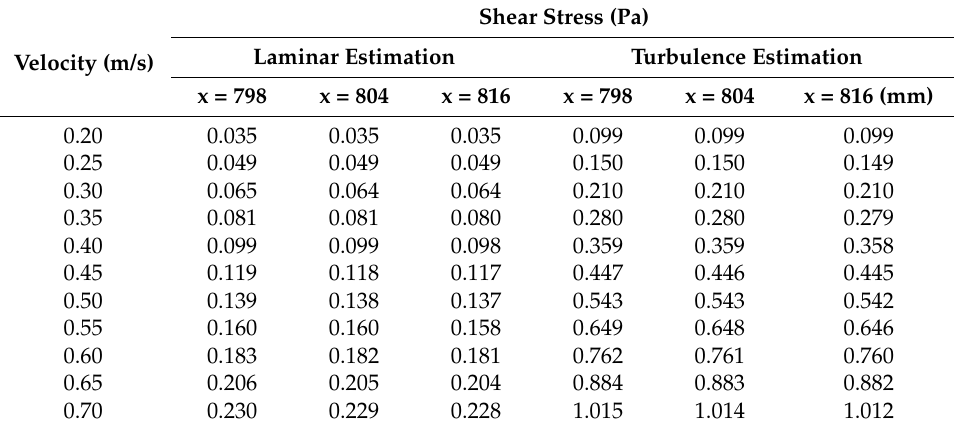
Table 3. Shear stress calculated by empirical